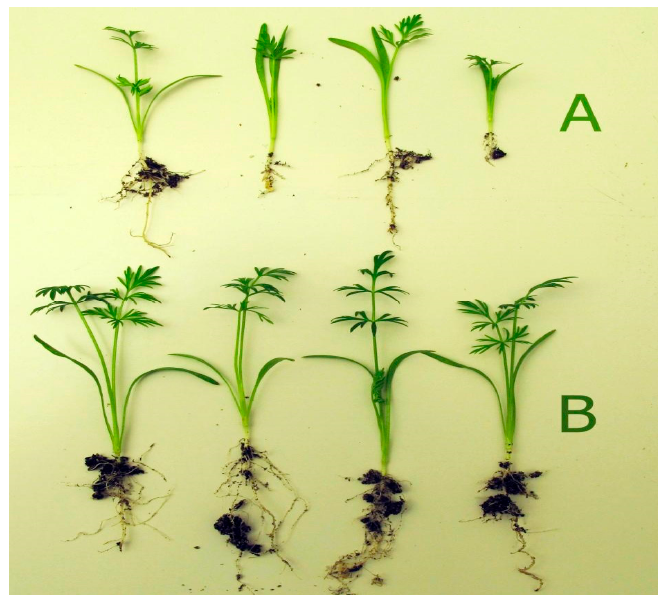
Figure 2. Caraway seedlings (25 days old) ( A ) from non-primed seeds and ( B ) from primed seeds with 5% PEG for 24 h.